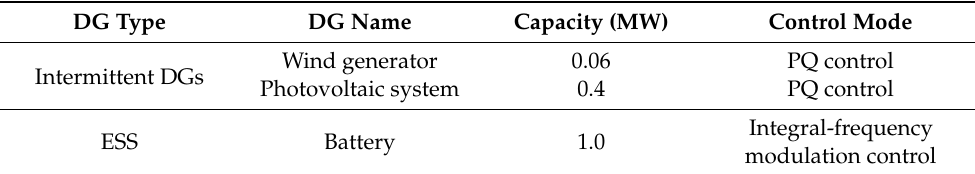
Table 1. Capacity and control method of